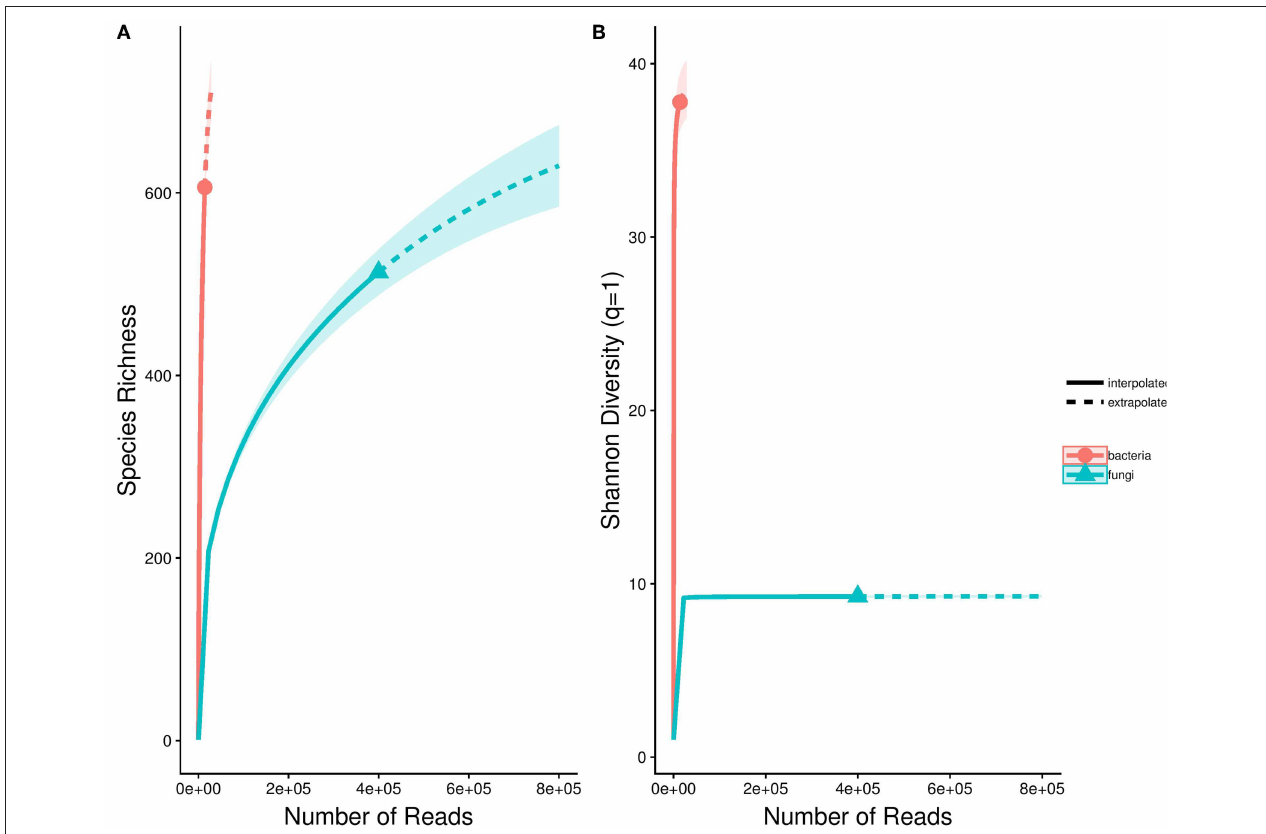
FIGURE 1 | Species accumulation curves for bacterial and fungal endophytes detected in the sample pool. These are represented using abundance-based Hill numbers, which take rare sequences into account through a scaling parameter of diversity termed q. (A) Richness ( q = 0), (B) Shannon diversity ( q ∼ 1). Dashed line indicates projected